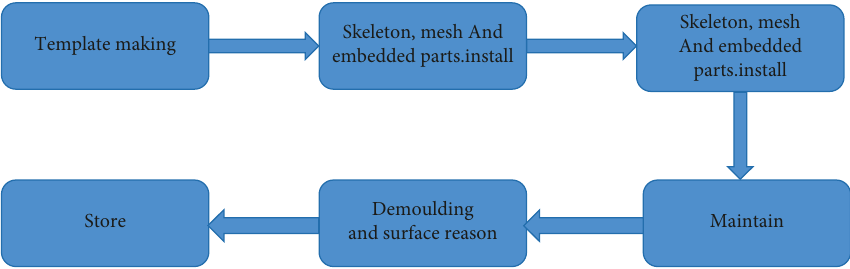
Figure 4: Production tracking node.